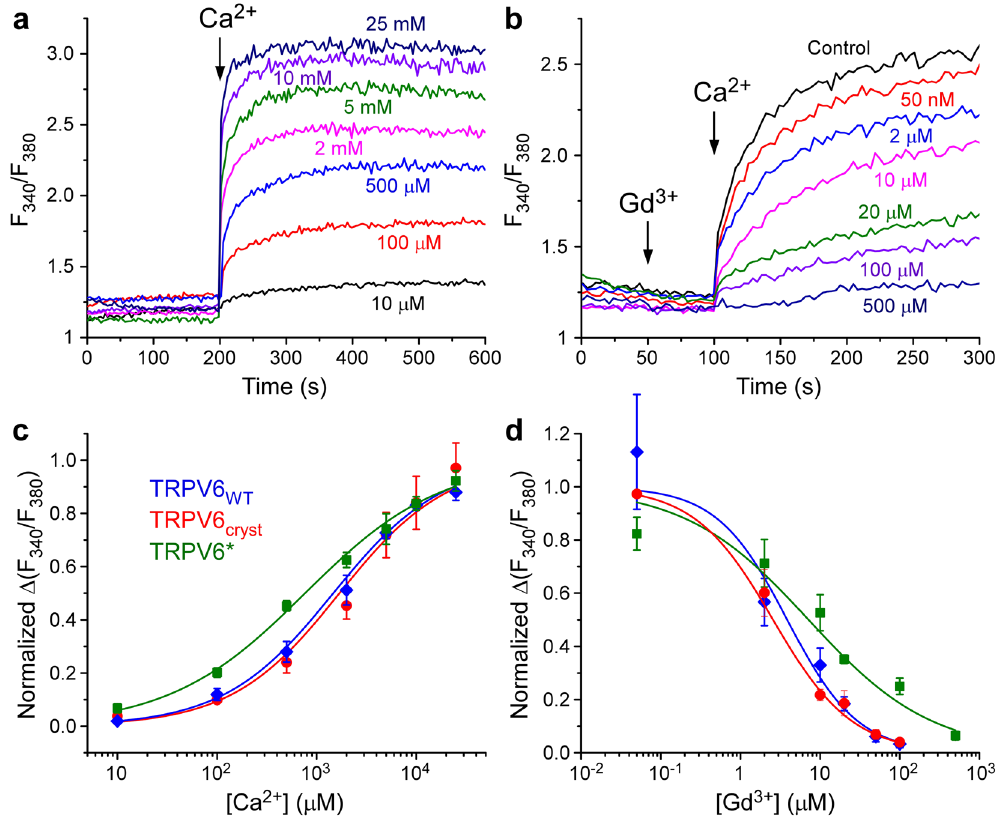
Figure 5. Ca 2 + permeability and Gd 3 + block are preserved in TRPV6 constructs with distinct domain arrangements. ( a , b ) Representative ratiometric fluorescence measurements for HEK cells expressing TRPV6 * . Arrows indicate the time at which the corresponding ion was added. After resuspending the cells in nominally calcium-free buffer, addition of Ca 2 + resulted in robust concentration-dependent increase in Fura-2 signal ( a ). In contrast, pre-incubation of cells with increasing concentrations of Gd 3 + resulted in concentration-dependent reduction in Fura-2 signal ( b ). ( c , d) Normalized changes in F 340 /F 380 at varying concentrations of Ca 2 + ( c ) and Gd 3 + ( d ) calculated for wild type TRPV6 (blue), TRPV6 cryst (red) and TRPV6 * (green). In ( d) , Δ F 340 /F 380 was measured after preincubation with Gd 3 + and subsequent addition of 2 mM Ca 2 +